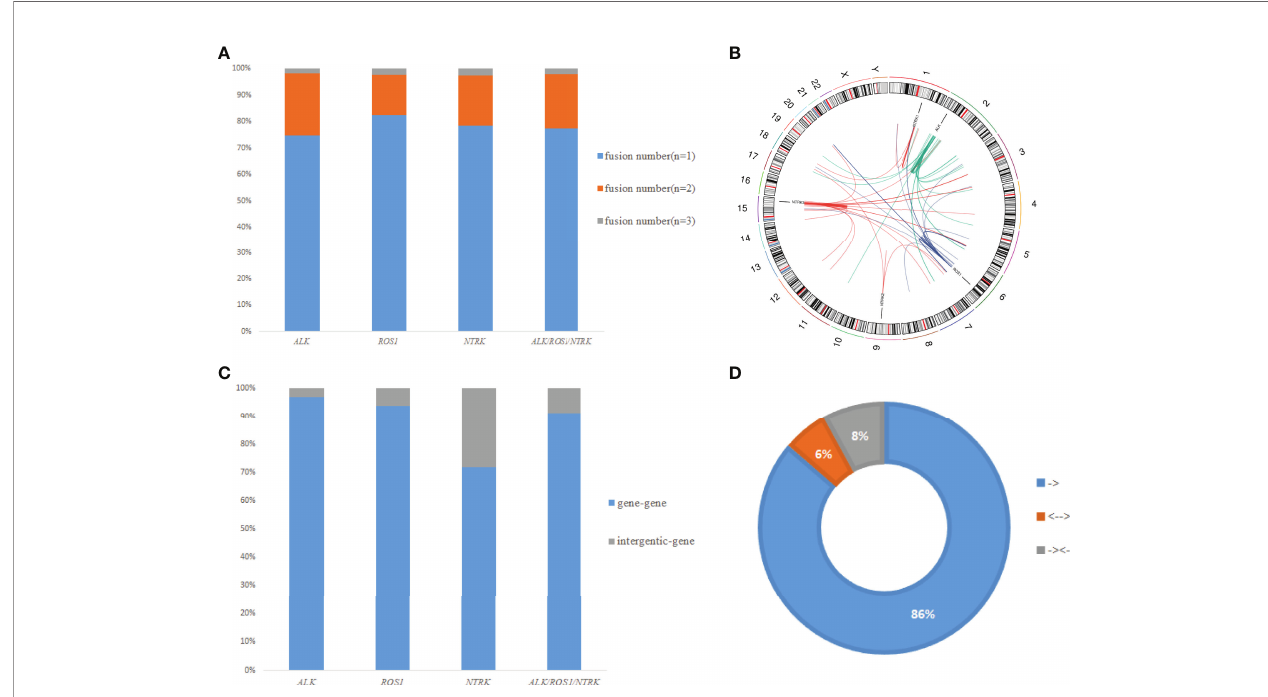
FIGURE 4 | Classi fi cation of fusion events. (A) Distribution of different fusion numbers (n=1, 2, 3) in our study. (B) A circos plot of 225 gene fusions identi fi ed in all patients. (C) Distribution of different fusion types (gene-gene and gene-intergenic). (D) Distribution of fusions with different formation